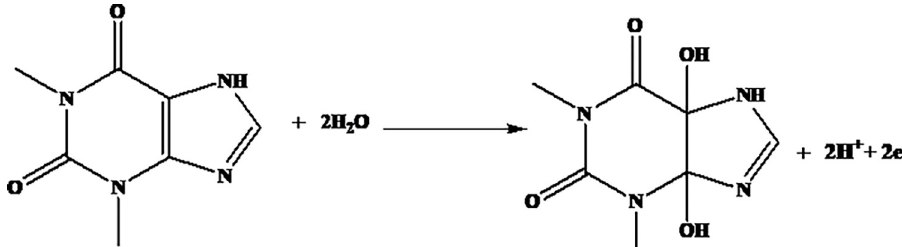
Fig 8. Proposed oxidation reaction mechanism of TP at